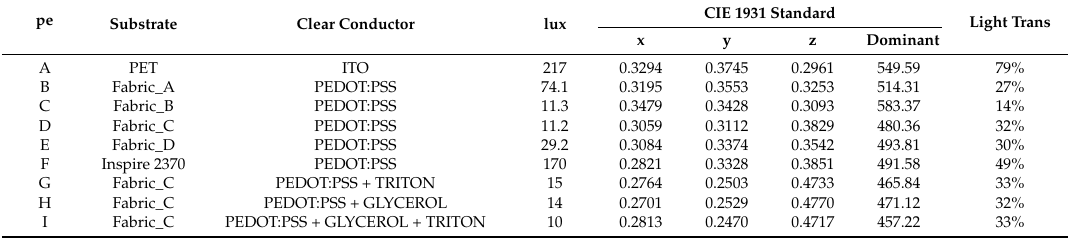
Table A2. Light characteristics of the different samples